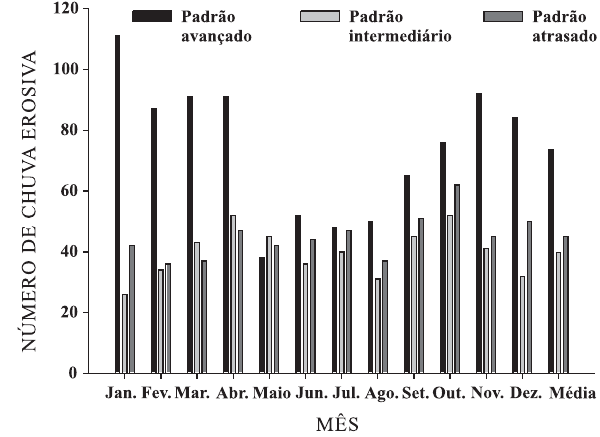
Figura 4. Distribuição do número total mensal por padrões hidrológicos das chuvas erosivas de São Borja, RS, no período de 1956 a 2003.